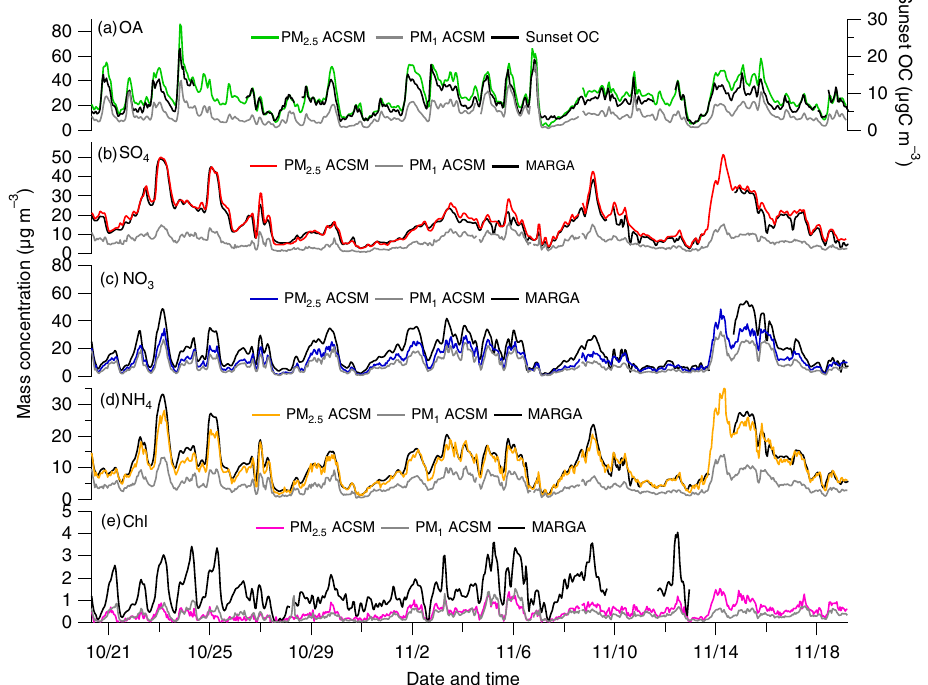
Figure 2. Intercomparisons between the NR-PM 2 . 5 mass concentrations measured by the PM 1 and PM 2 . 5 ACSMs and the data acquired by collocated instruments: (a) organics vs. PM 2 . 5 OC by a Sunset Lab OC / EC analyzer, and (b–e) sulfate, nitrate, ammonium, and chloride vs. those measured by the PM 2 . 5 MARGA. Dates are indicated in mm/dd format.